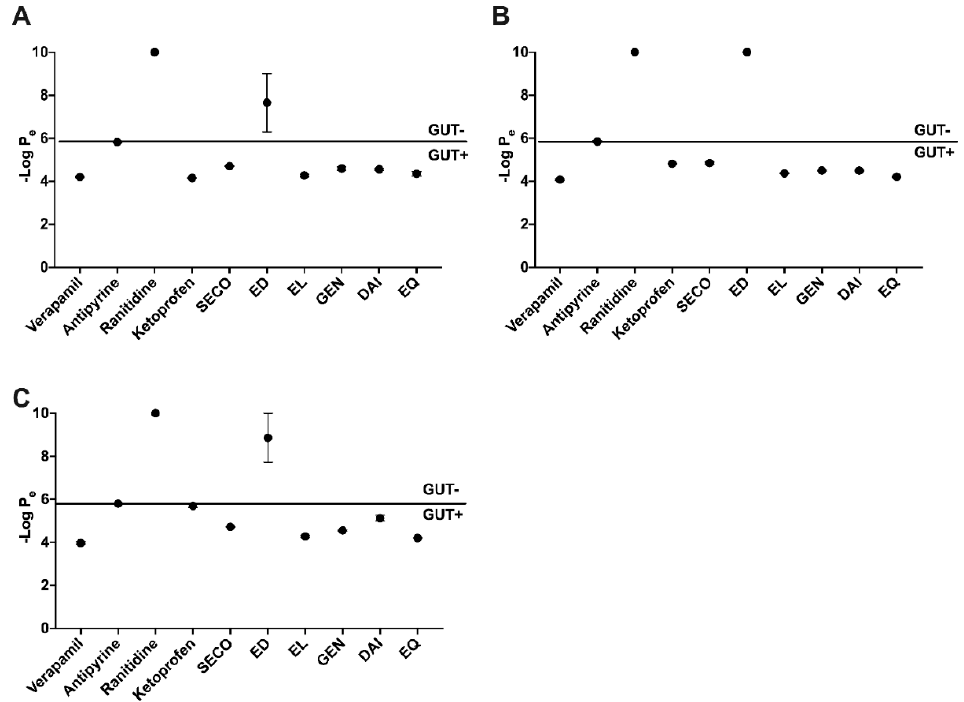
Figure 2. Parallel artificial membrane permeability assay (PAMPA) gut passive permeability at three relevant pH levels: 5.0 ( A ), 6.2 ( B ), and 7.4 ( C ). Controls verapamil, antipyrine and ranitidine exhibit high, medium and low penetrability, respectively. Ketoprofen shows variable permeability with pH change.